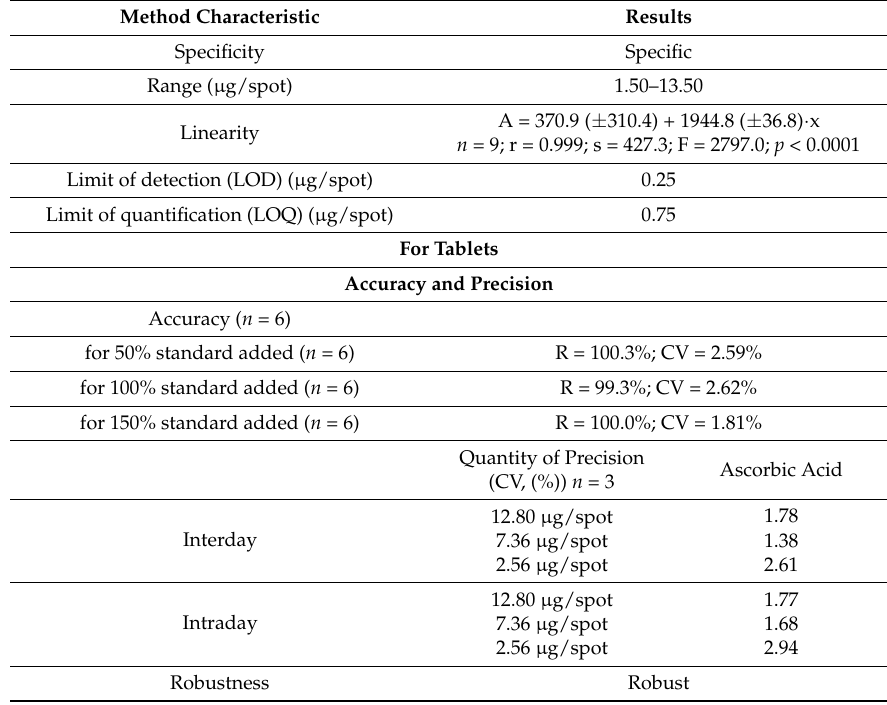
Table 1. The method validation data for the quantitative determination of ascorbic acid by NP-TLC (normal phase thin layer chromatography) with a densitometry a .